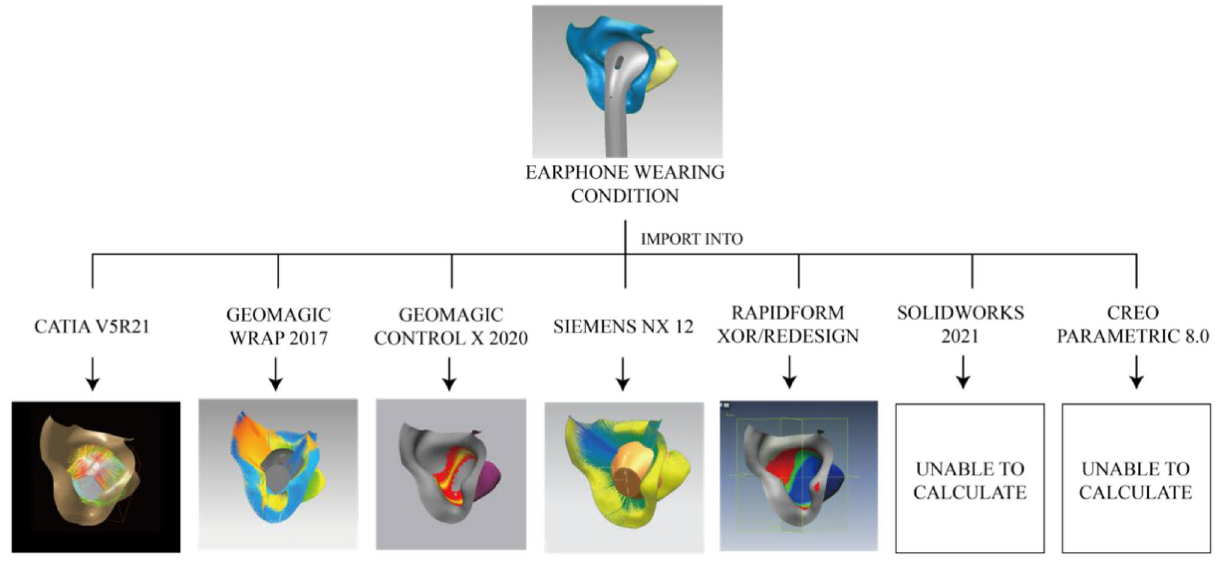
Figure 3. Deviation analysis effect between earphone (with only body portion) and ear (with only concha part) calculated by seven commercial CAD tools (CATIAV5R21, Geomagic Wrap 2017, Geomagic Control X 2020, Siemens NX 12, Rapidform XOR/Redesign, Solidworks 2019, Creo Parametric